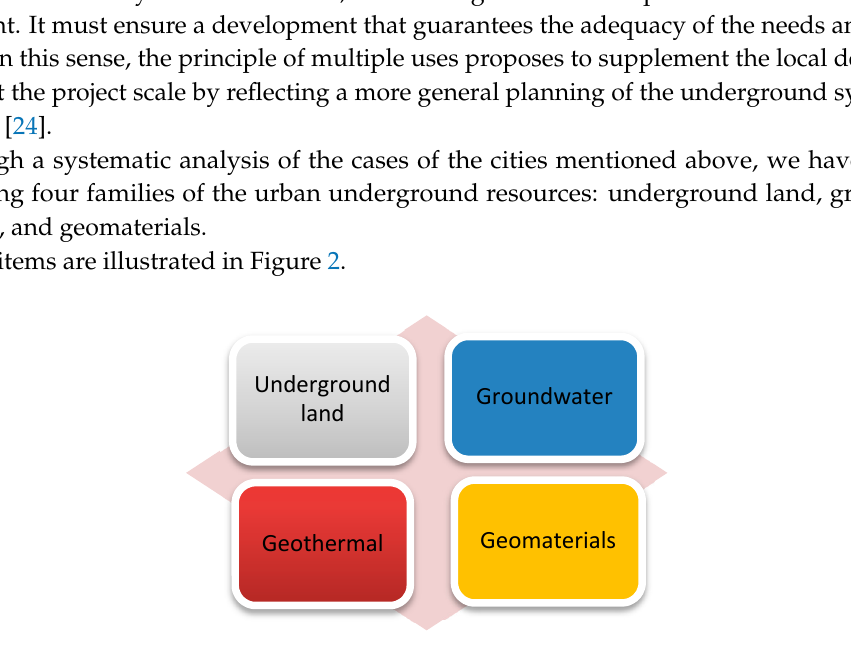
Figure 2. The resource families of urban underground spaces.